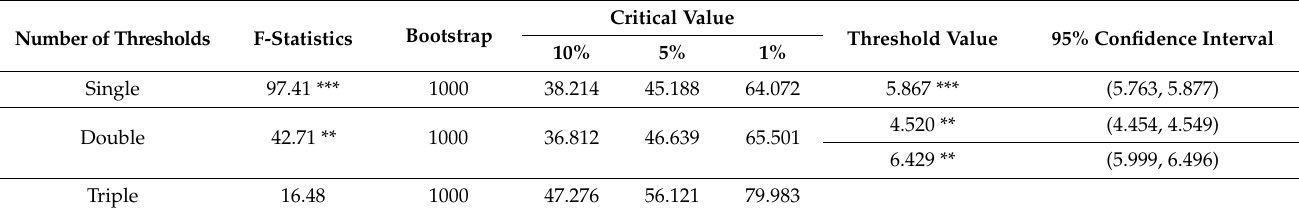
Table 6. The results of the threshold effect tests.